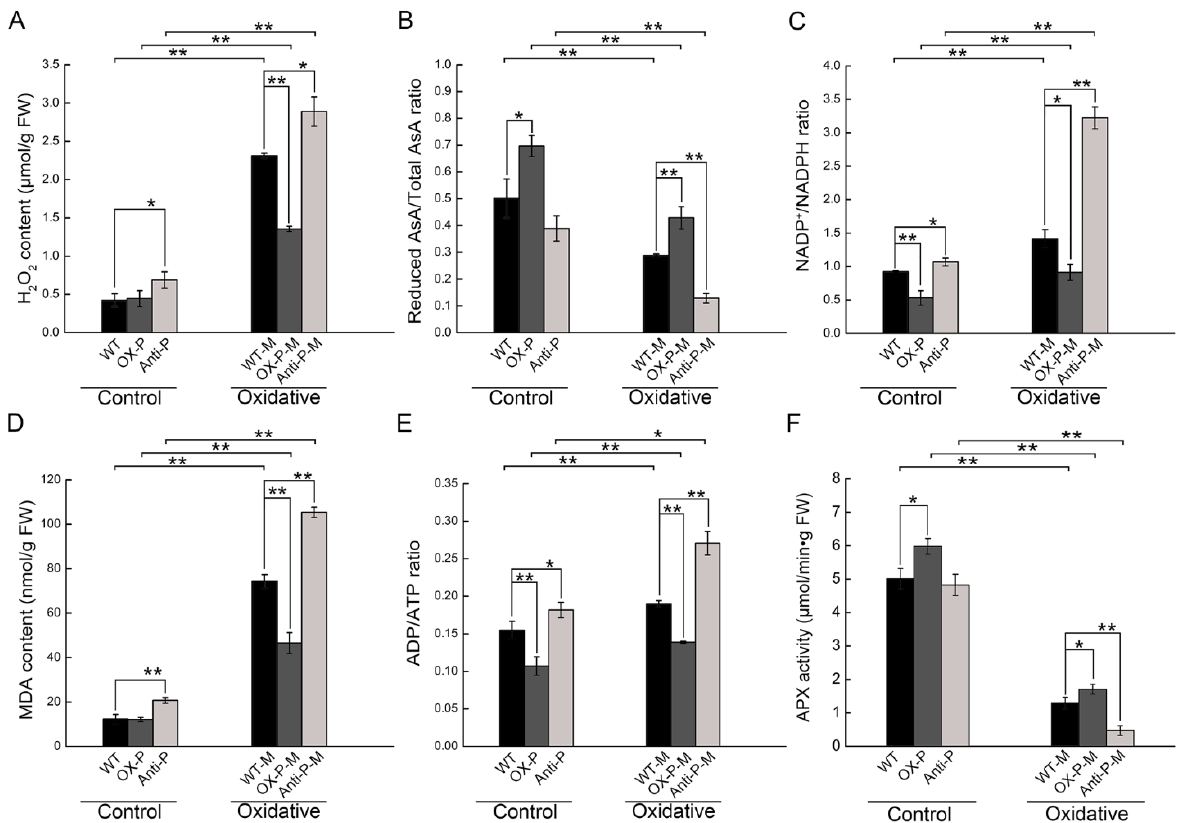
Figure 4. The change in chloroplast oxidant or reduced contents in leaves under 100 μ M MV for 5 h. ( A ), Chloroplast H 2 O 2 content; ( B ), Reduced AsA/total AsA ratio; ( C ), NADP + /NADPH ratio; ( D ), Chloroplast MDA content; ( E ), ADP/ATP ratio; ( F ) APX activity. WT-P-M, WT treated with MV; OX-P-M, OX-P treated with MV; anti-P-M, anti-P treated with MV. All values are means ± SD ( n = 3). Significant differences between mean values are indicated by asterisks using Student’s t -test. ** and * indicate p < 0.01 and p < 0.05, respectively.